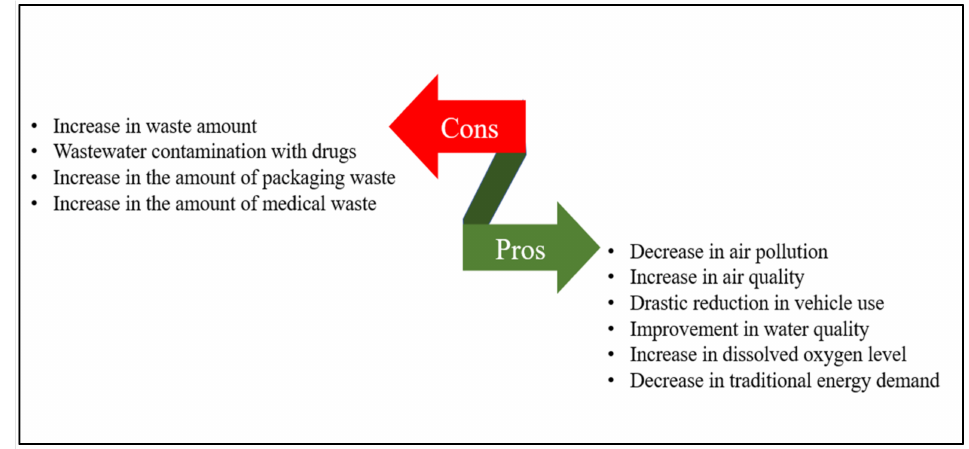
Figure 6. Pros and cons of COVID-19 lockdown restrictions on the